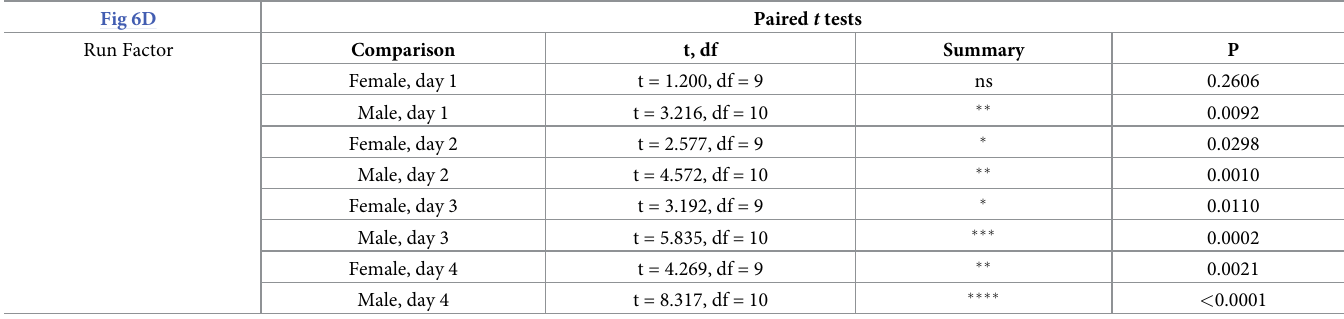
between Runs or session-wise improvement (Fig 9E). Session-wise differences in AUC were minimal for both sexes during both Runs (Fig 9B). Sex differences were insignificant for both Runs as well (Fig 9C). The only significant difference between Runs was in O-AUC for females Table 9. Statistical analysis of data shown in Fig 6D for place learning with corner switch, cohort B, Run comparison. Fig 6D Paired t tests Run